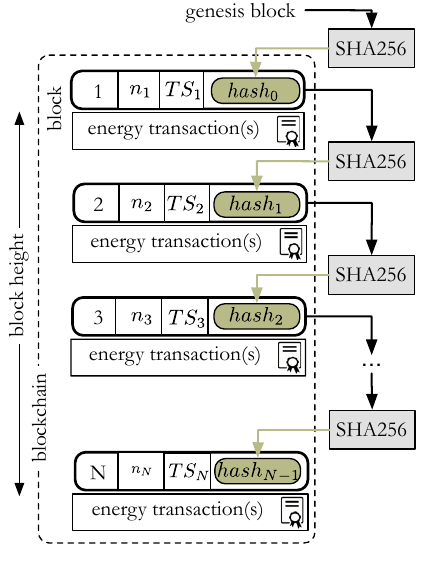
Fig. 1: Simplified conceptual scheme of an energy blockchain. Figure 1. Blockchain